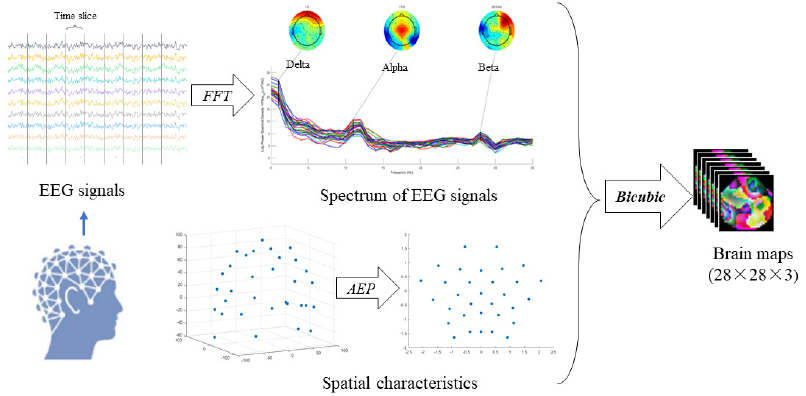
Figure 3. The preprocessing of EEG